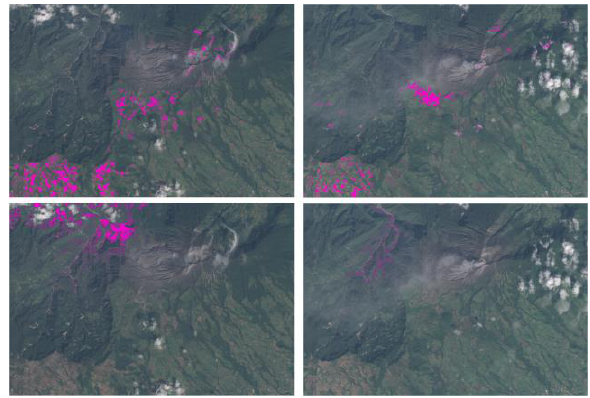
Figure 10. Occurrence maps of local shapes found in the discrete spectral profiles of the two Sentinel 2 images. Maps highlighting parts of clusters red and yellow on 26/01/2017 (left up) and on 12/12/2018 (right up). Maps highlighting parts of cluster dark blue on 26/01/2017 (left down) and on 12/12/2018 (right